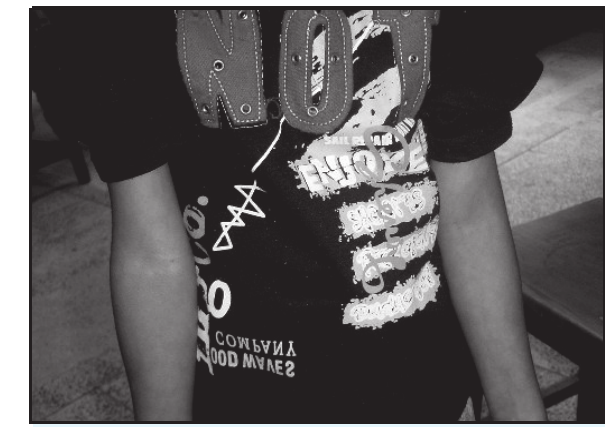
Figure 7. comparison of carrying angle of both elbows shows almost similar